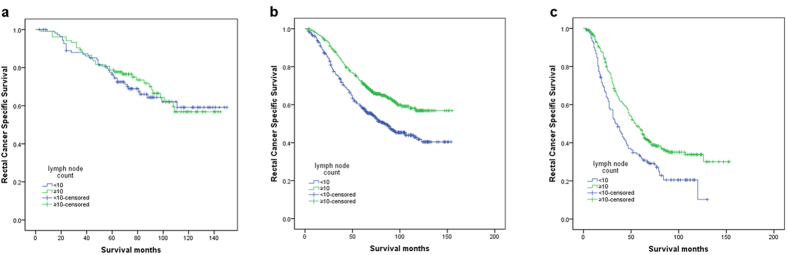
Log-rank tests of rectal cancer cause-specific survival comparing patients with ≥10 lymph nodes with patients who had <10 nodes for (a) stage ypIIIA: χ2 = 0.121, P = 0.728; (b) stage ypIIIB: χ2 = 22.817, P < 0.001; and (c) stage ypIIIC: χ2 = 13.225, P < 0.001.